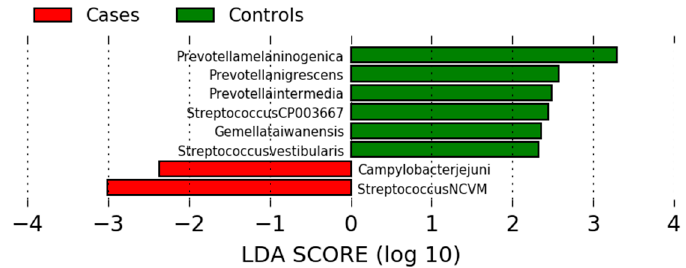
Figure 2. Linear discriminant analysis (LDA) of effect size (LEfSe) analysis plot for taxonomic species.